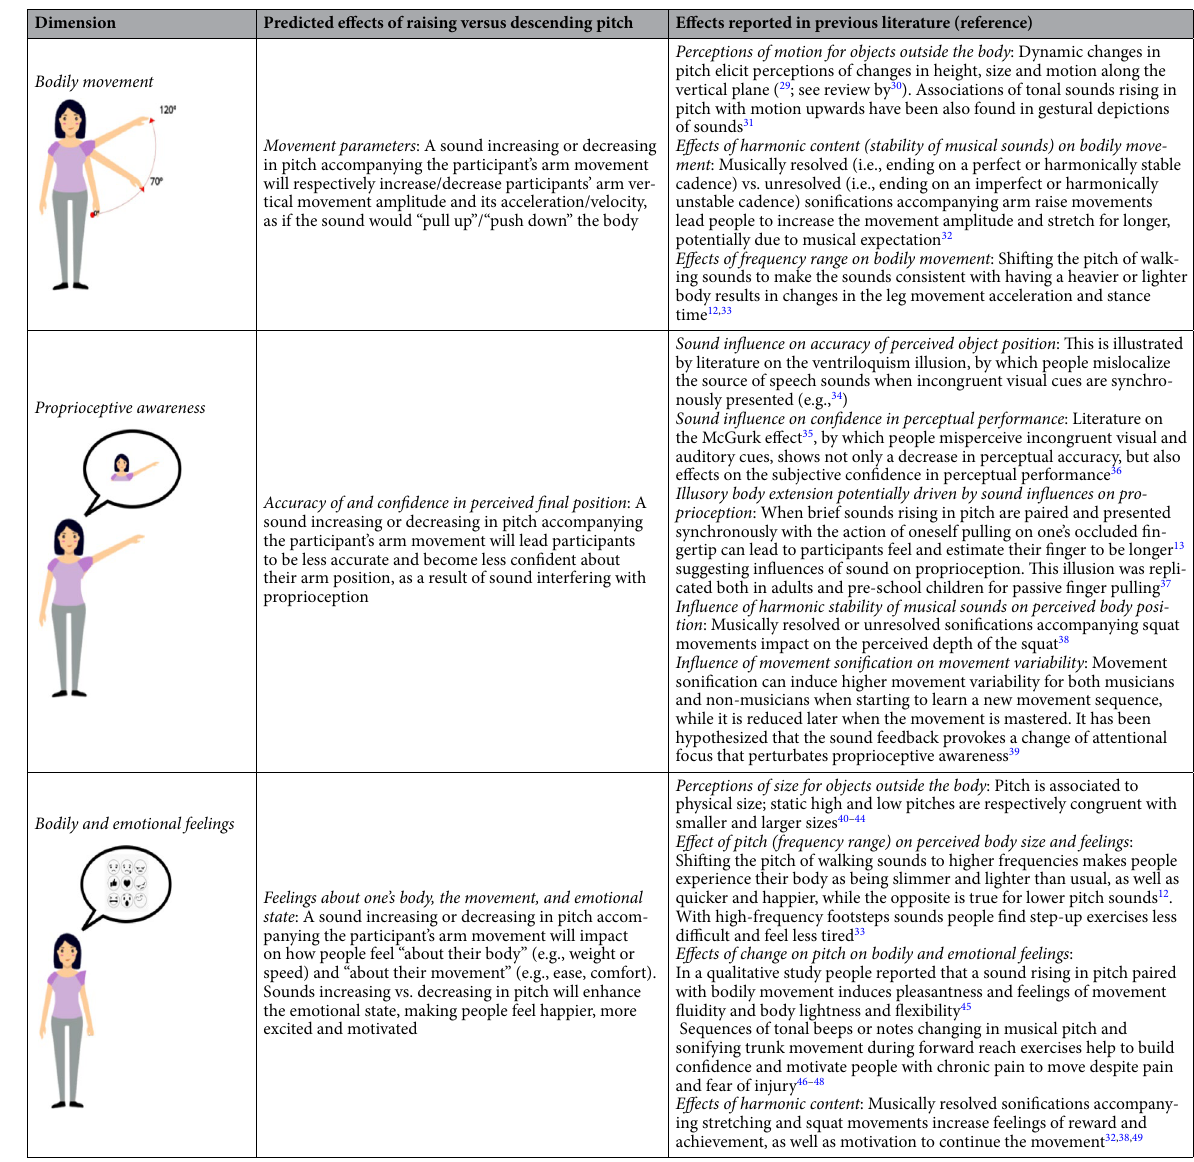
Table 1. Specific predictions/replications for the robust effect of pitch changes across all the